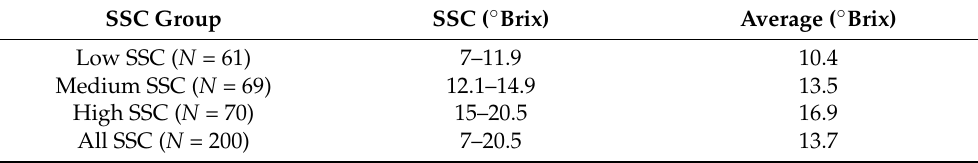
Table 1. Variation of SSC by different SSC level grouping (Low, Medium, High).